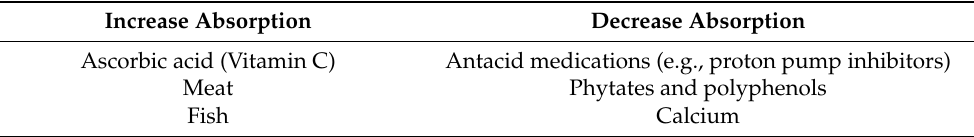
Table 2. Foods and medications that either enhance or inhibit the absorption of iron heme and non-heme iron